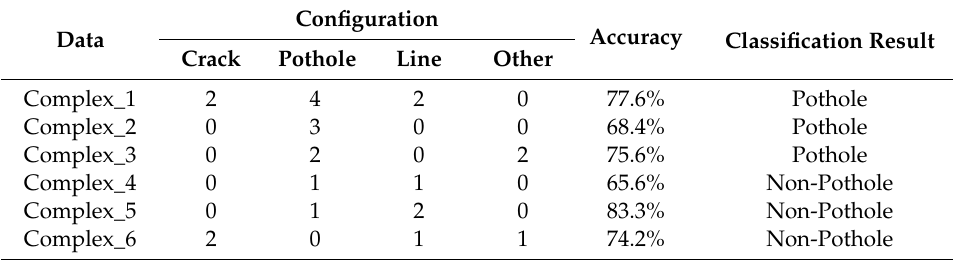
Table 4. The classification results for potholes and other road